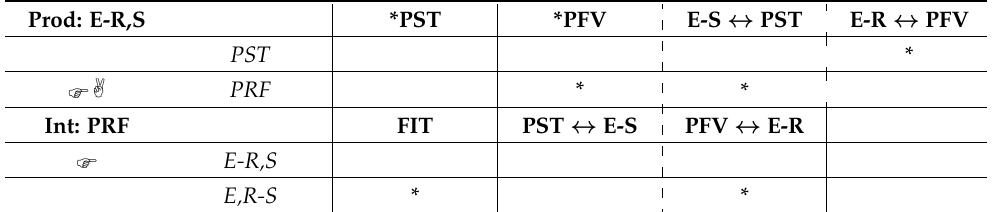
Tableau 3. Symmetrical optimization in French, German, and Dutch (example (12)). Tableau 2. Asymmetrical optimization in English and Spanish (example (12)). Tableau 1. Bidirectional optimization of tenses. Tableau 2. Asymmetrical optimization in English and Spanish (example (12)).